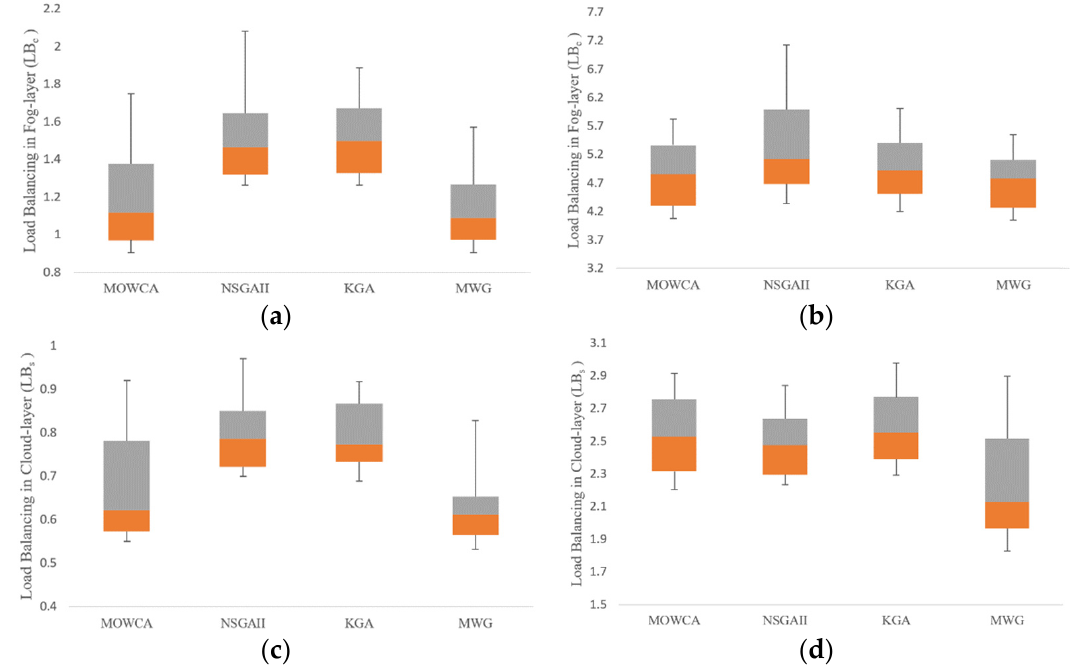
Figure 5. Comparison between algorithms due to the distribution of different solutions’ load balancing in the resulted Pareto after 100 iterations for ( a ) 100 data items in the fog layer, ( b ) 400 data items in the fog layer, ( c ) 100 data items in the cloud layer, and ( d ) 400 data items in the cloud layer.